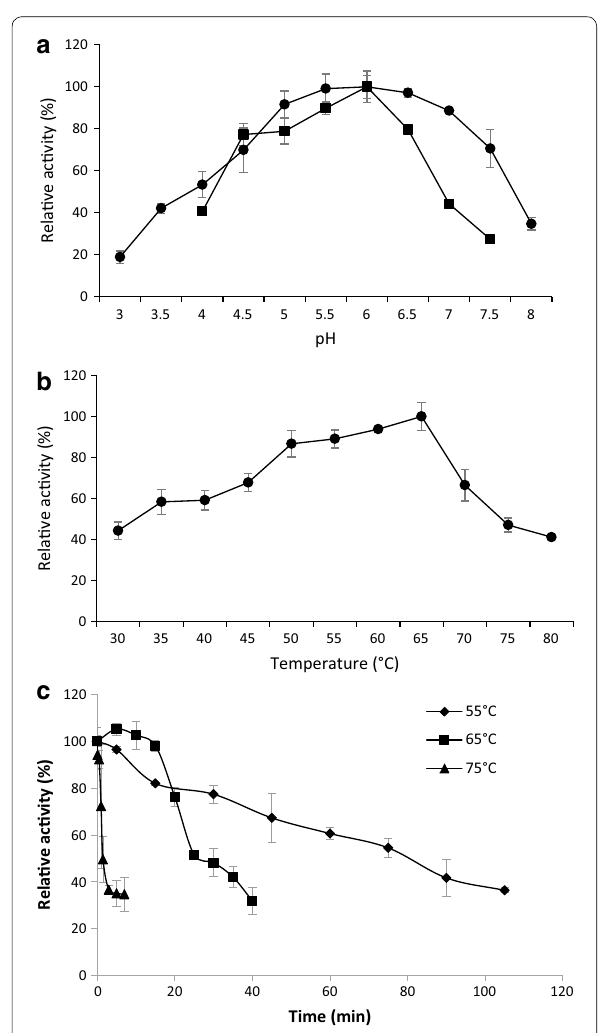
Fig. 5 Effect of pH and temperature on Lr XynA activity and stability. a Effect of pH on xylanolytic activity (Black circle) and stability (Black square) of Lr XynA. Lr XynA was incubated in 50 mM citrate–phosphate (3–7) or phosphates (6–8) buffer and incubated at 50 °C for 10 min; for pH stability, Lr XynA was preincubated at 50 °C for 3 h in the same buffers. b Effect of temperature on the xylanolytic activity of Lr XynA. The enzyme was incubated in 0.2% (w/v) Beechwood xylan in 50 mM citrate–phosphate buffer, pH 6.0 at different temperatures (30–80 °C). c Thermostability of Lr XynA at 75 °C (Black up‑pointing triangle), 65 °C (Black square) and 55 °C (Black diamond